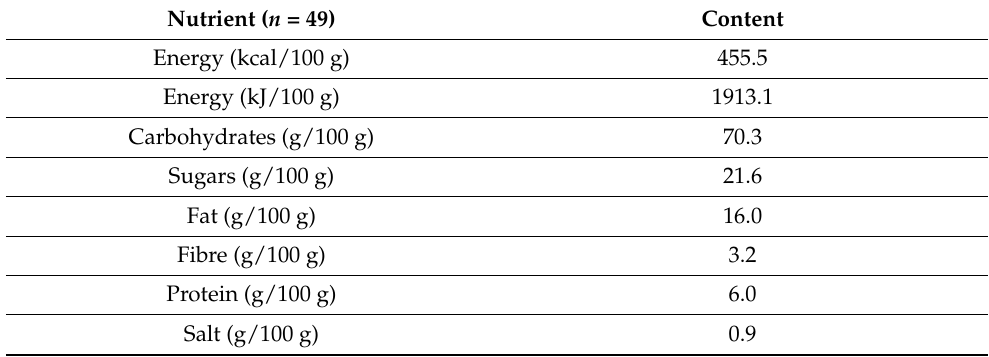
Table 8. The average nutritional content of 49 different plain biscuits targeted at children (aged 5–12) sold in Spain between 2017 and 2022. Data found in Mintel GNPD Database (October